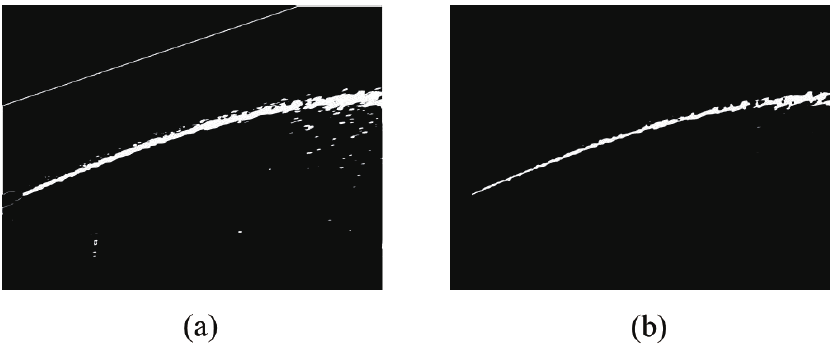
Figure 6. Results image with morphological treatment. (a) Original image; (b) morphologically processed